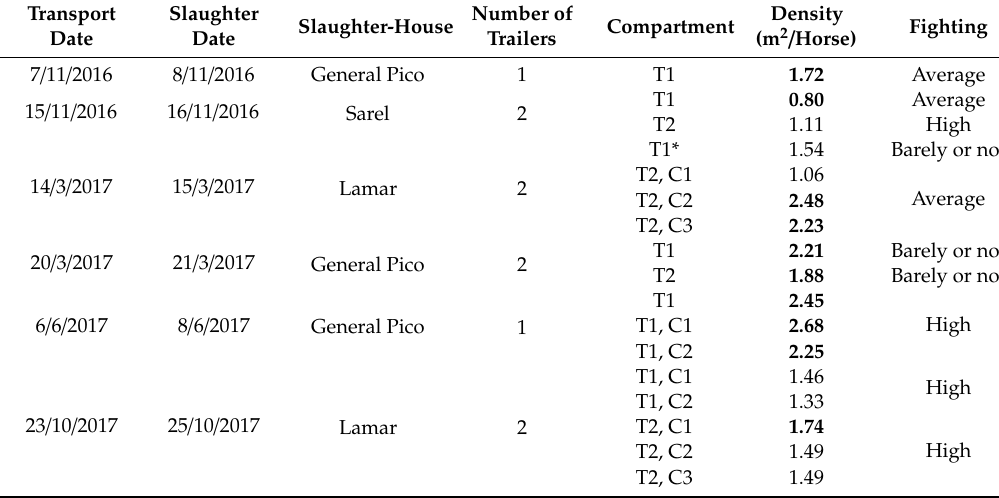
Table A6. Density per compartment of the transports with deviating density in one or more compartments. Densities in bold deviate from the norm. * = unknown distribution. T1 = front loading space; T2 = hind loading space; C1 = first compartment; C2 = second compartment; C3 = third